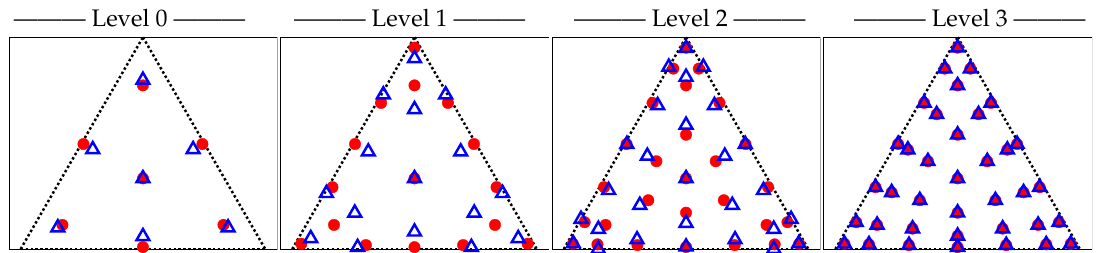
Figure 6. Quadrature points generated on one element